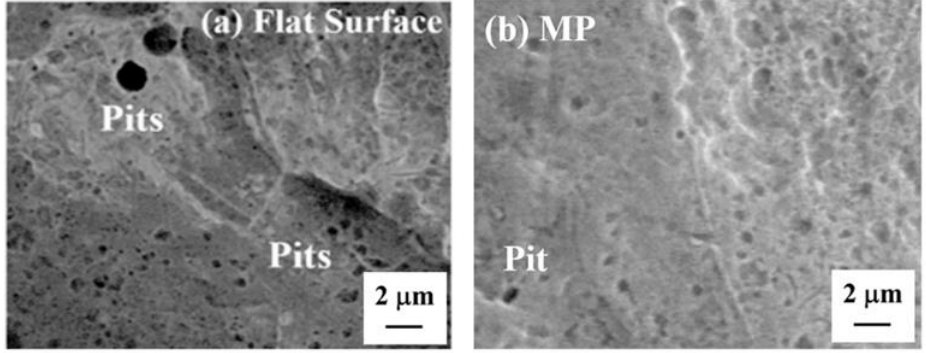
Figure 7. Representative SEM pictures: ( a ) surface of flat sample [1] and ( b ) surface of a micropillar (MP), after corrosion test (upon continuous contact with 3.5 wt.% NaCl solution).